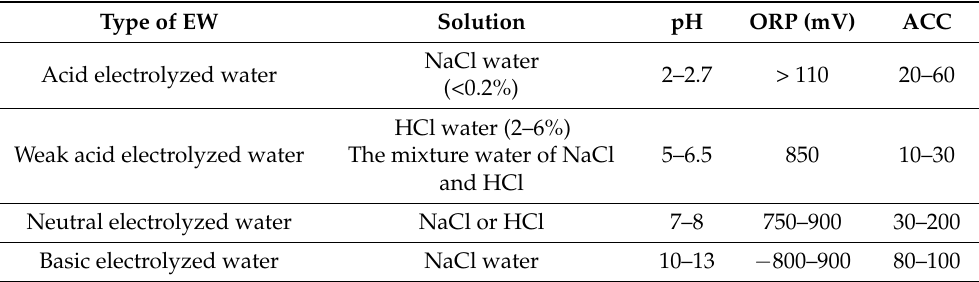
Figure 1. Schematic diagram of basic and acidic electrolyzed water. Table 1. The characteristics of